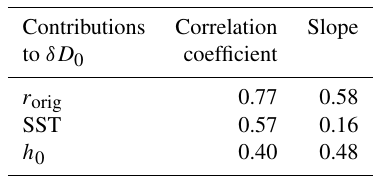
Table 6. Same as Table 2 but for the STRASSE observations. Linear regressions are calculated among 1977 data points.